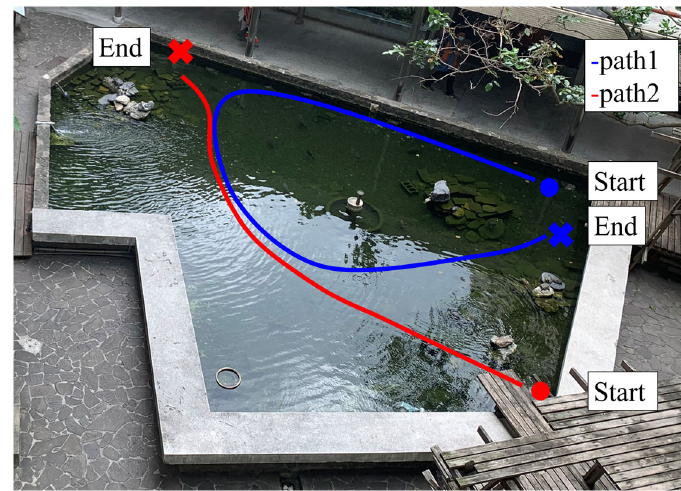
Figure 12. Two paths tested in established waters.